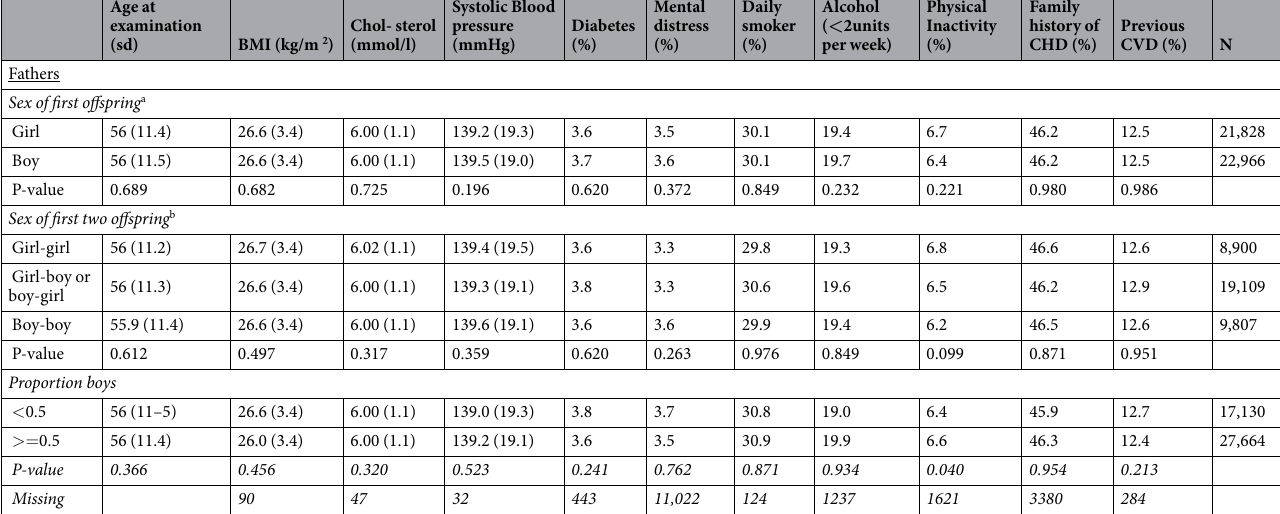
which is supported by findings in the CONOR sub-cohort where the (imprecisely estimated) greater association in women for CVD was not attenuated after adjusting for important risk factors. In general differential associations of offspring sex with parental health may mechanisms that are biologically or socially informative, even if effect sizes are small. Sons and daughters may provide emotional, interpersonal, financial and material support to the parents, which may be gendered 41 . Studies in societies with strong preference towards sons, such as China and Bangladesh, are at odds with this, suggesting a context specific association: In Bangladesh there was an increased survival accord- ing to number of sons, possibly due to improved parental socioeconomic circumstances consequent on this. Maternal-fetal exchange of genetic material (fetal microchimerism) has been suggested to have health impli- cations for both the fetus and the mother 42 . Half of the fetal tissue antigens have paternal origin and maternal immune reactions must be suppressed or tolerated to continue the pregnancy 43 . With a male fetus, the maternal immune system is exposed to male antigens that may give rise to long-lasting immunity against male-specific antigens. Such male-specific antigens have been found to give higher risk of graft-versus-host disease in stem-cell transplantation with female donors to male recipients 44 . Such changes affect immune tolerance, energy metabo- lism and cardio-respiratory function, all triggered by the feto-placental unit 26 . Our study found no reflection of this in rheumatoid arthritis, coeliac disease, crohn’s disease or ulcerative colitis, however. Micro-vascular vasodilatation is enhanced in women with a male fetus 45 . In preeclampsia, this vasodilatation is reduced in women with a male but not a female fetus, compared to a normal pregnancy. There is also growing evidence that the physiological adjustments do not return to the pre-pregnancy state when pregnancies are com- plicated by certain diseases, such as preeclampsia and gestational diabetes 46 . These conditions may occur due to pre-existing subclinical disease, later manifest in CVD, autoimmune disease or early maternal mortality, creating an additional burden of disease for the mother. Our sub-analysis on perinatal death, pre-eclampsia, perinatal deaths did not support this.